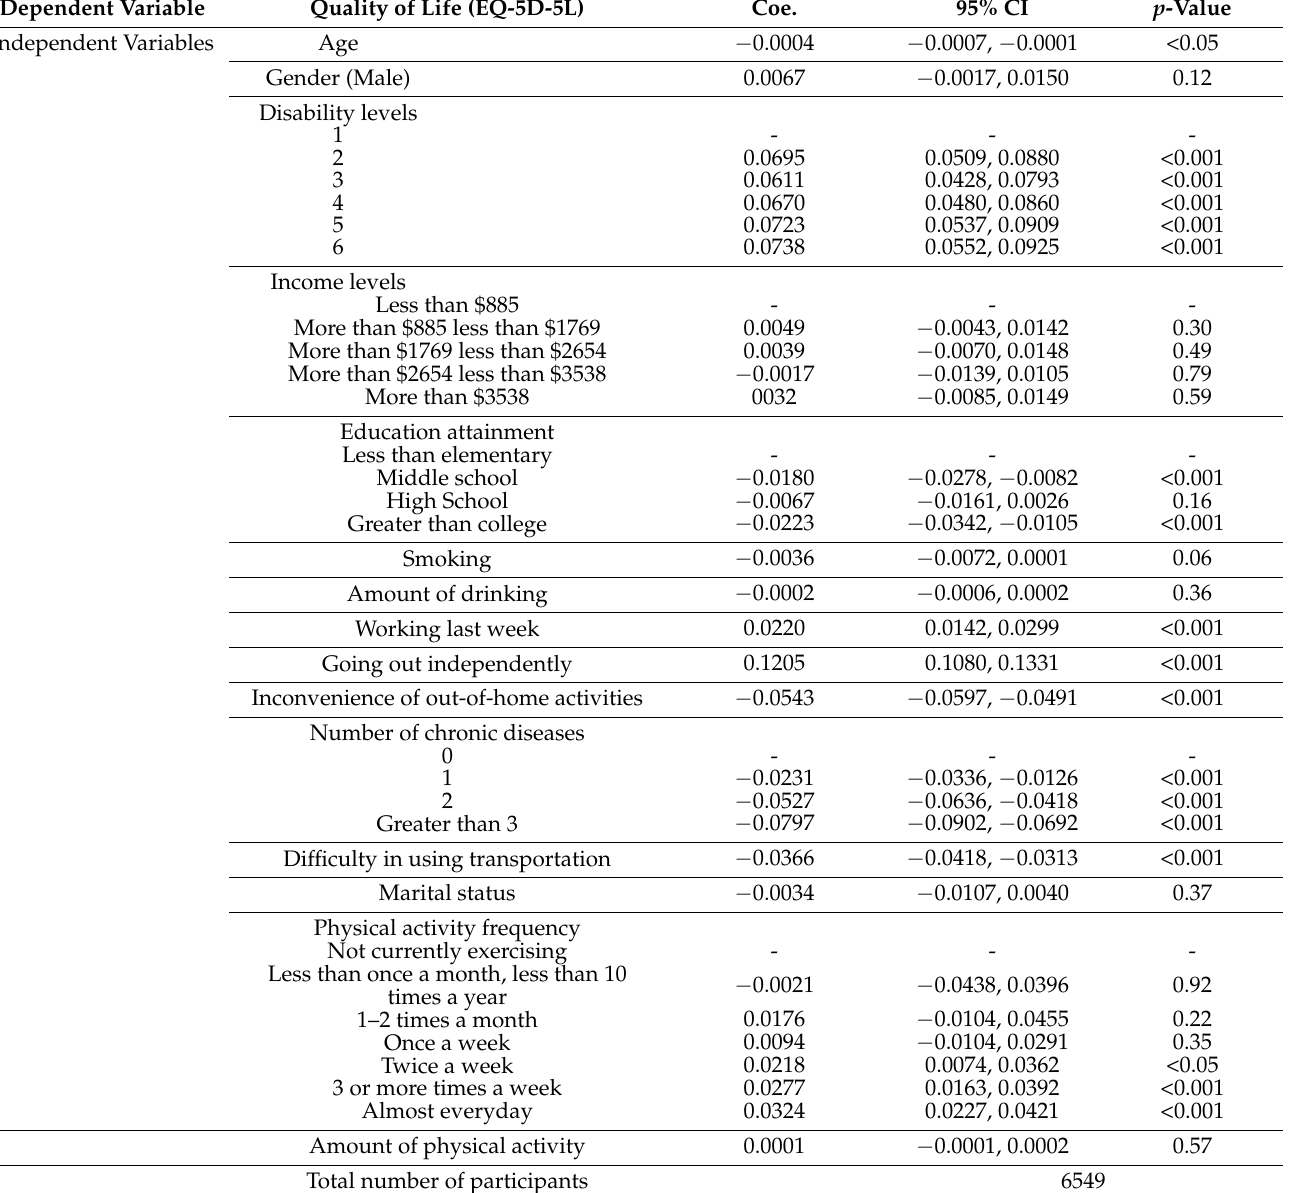
Table 2. Multivariate linear regression of physical activity and health-related conditions on quality of life for people with